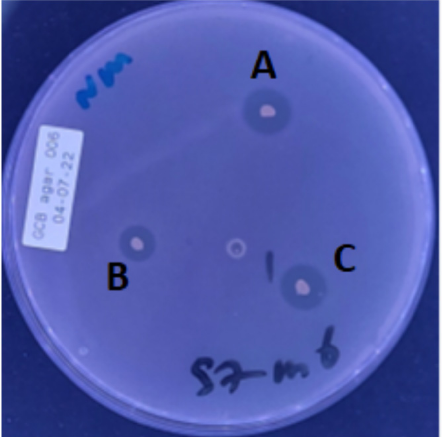
Figure 1. Agar overlay assay showing inhibitory activity by some isolates to N. meningitidis M00003/1: A, Rothia dentocariosa B, Streptococcus mitis and C, Rothia dentocariosa .